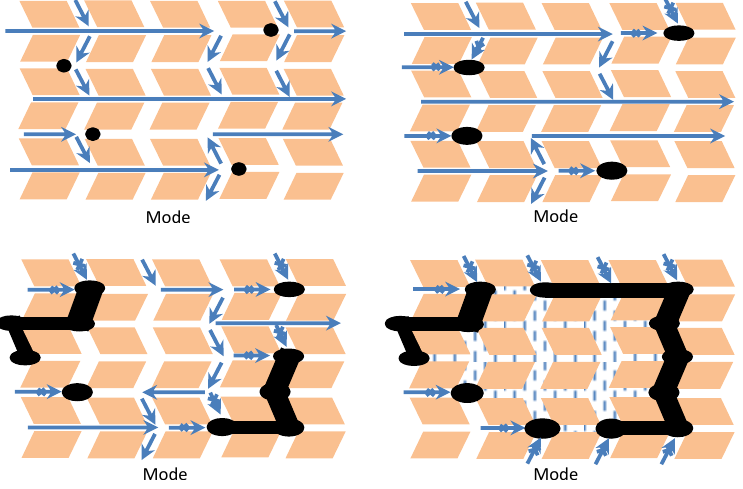
Figure 16. Schematic of the four possible modes of deactivation by carbonaceous deposits in HZSM-5: (1) reversible adsorption on acid sites, (2) irreversible adsorption on sites with partial blocking of pore intersections, (3) partial steric blocking of pores, and (4) extensive steric blocking of pores by exterior deposits. Adapted from